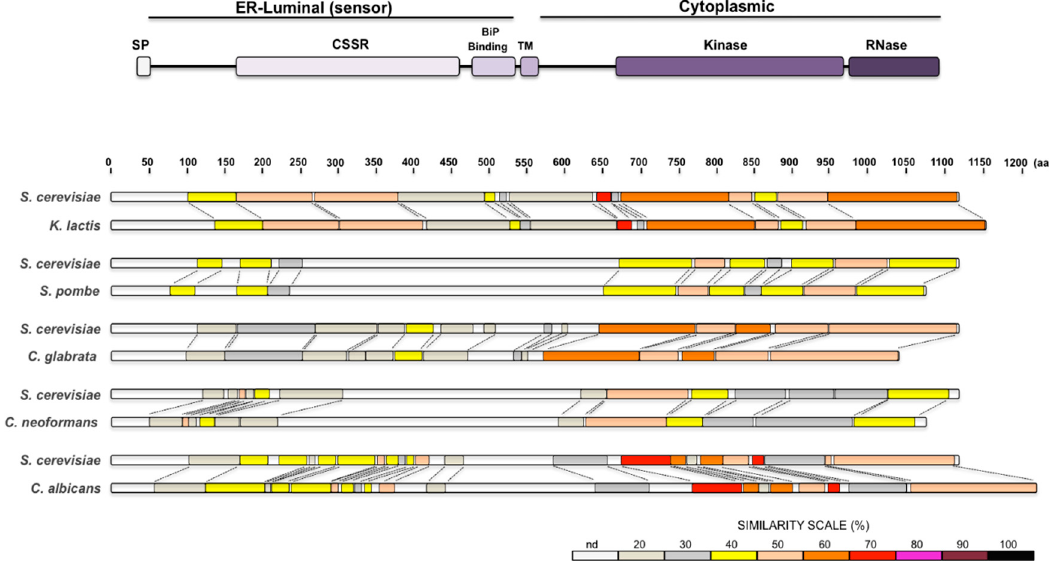
Figure 1. ( Top ) Diagram of the Ire1 protein structure. Signal Peptide (SP), Core Stress Sensing Region (CSSR), BiP Binding domain, Transmembrane segment (TM), and the Kinase and RNase domains were deduced from the S. cerevisiae Ire1 protein. ( Bottom ) Pairwise alignments between the S. cerevisiae , K. lactis , S. pombe , C. glabrata , C. neoformans and C. albicans , Ire1 orthologues. The Ire1 protein of each species is compared to the S. cerevisiae one. Protein sequences were analysed with SIM local alignment tool and results were visualized with LALNVIEW. Protein schemes are drawn to scale.